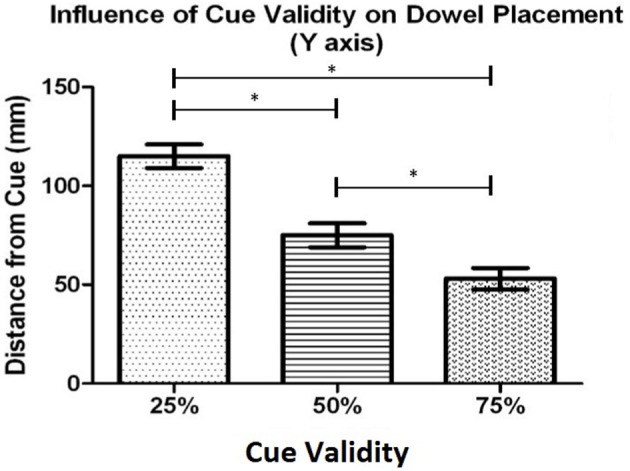
Experiment 1: Mean distance of the dowel from the cued location for each cue validity condition. Error bars represent the standard error of the mean. The * indicates a statistically significant difference.